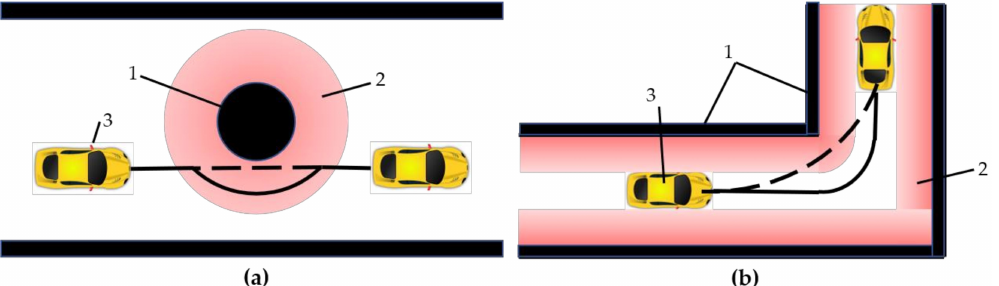
Figure 6. Schematic of the limitations of the traditional artificial potential field method. ( a ) is the range repulsion effect generated by randomly generated obstacles in the road, ( b ) is the range repulsion effect generated by the obstacles on both sides of the road that prevent vehicles from driving out. ( 1 ) is the obstacle, ( 2 ) is the range repulsion, and ( 3 ) is the virtual vehicle. The dotted line is the optimal path trajectory, and the solid line is the actual vehicle driving